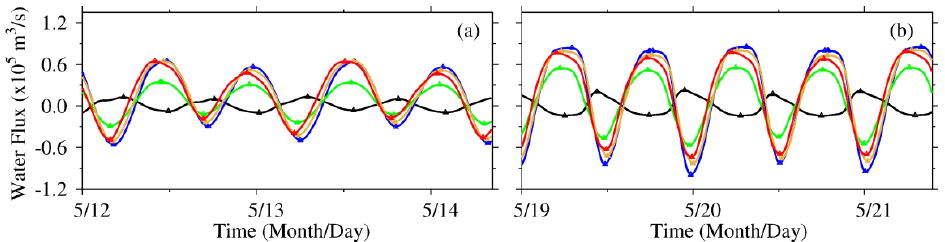
Figure 9. Temporal variations in the water fluxes across Sec.1 (black), Sec.2 (blue), Sec.3 (orange), Sec.4 (red) and Sec.5 (green) during the neap tide ( a ) and spring tide ( b ) in EX0. Sec.1: positive from south to north; others: positive from west to east. Triangles: positions of the peaks.